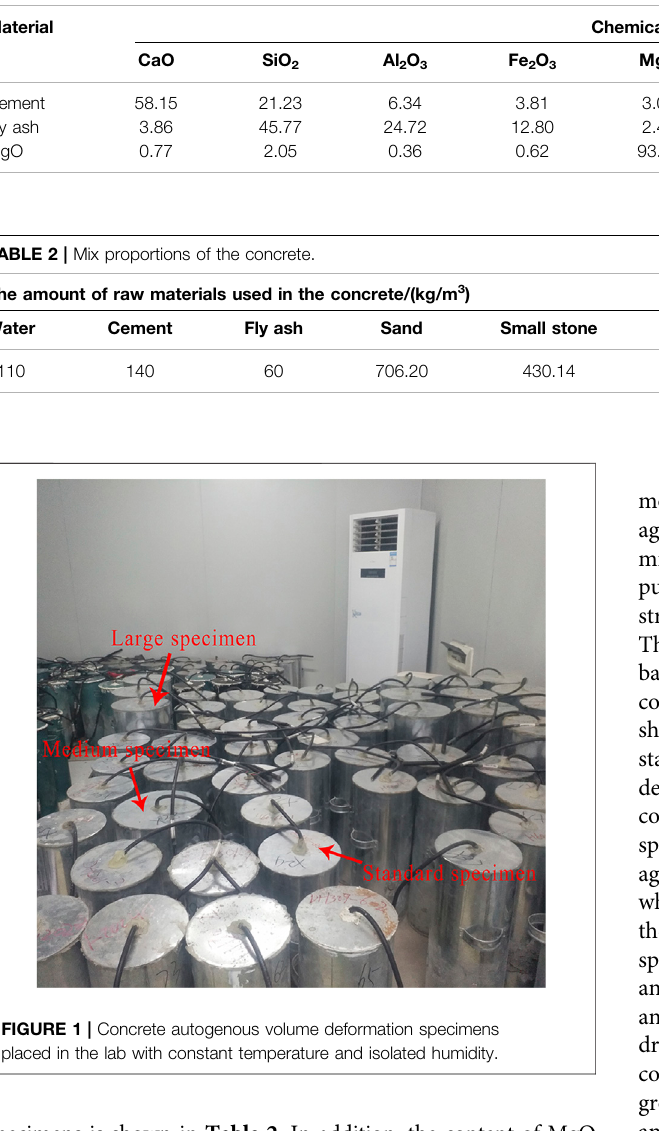
Frontiers in Materials |